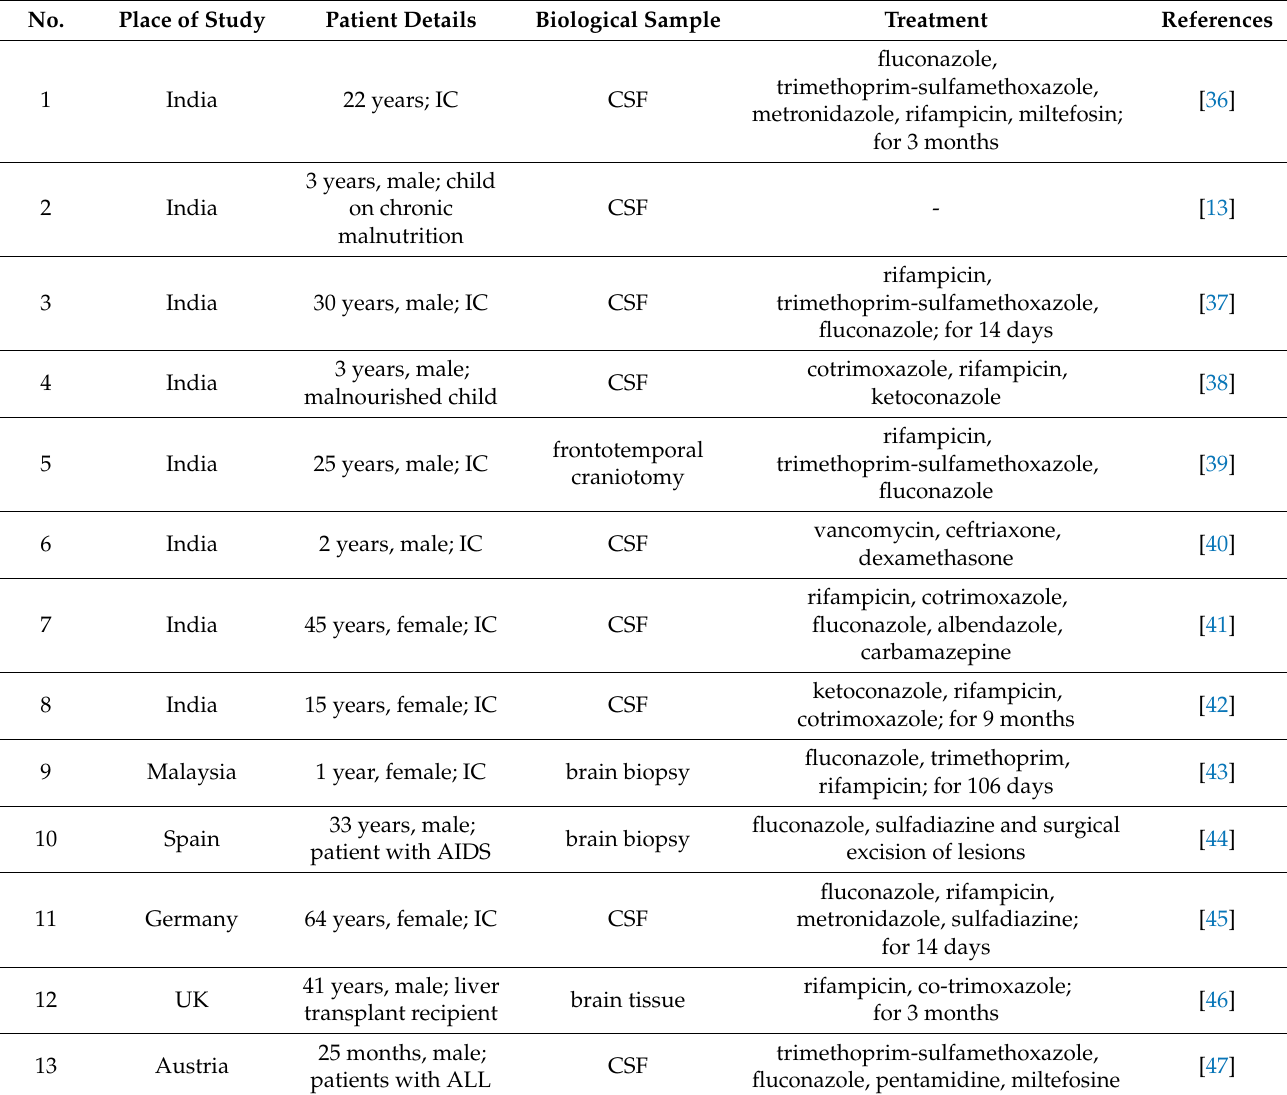
Table 1. Cases of survivors of granulomatous amebic encephalitis (GAE) caused by Acanthamoeba spp. reported during